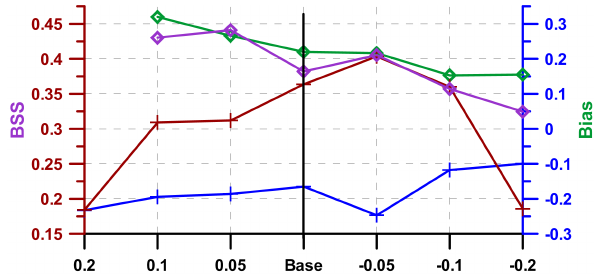
Figure 8. Morphodynamic sensitivity analysis. Badalona BSS ap- pears in red; Badalona bias in blue. The Mataró BSS is in purple; the Mataró bias in green. The x axis indicates the base simulation and the numerical results correspond to increments (or decrements) in the wind field